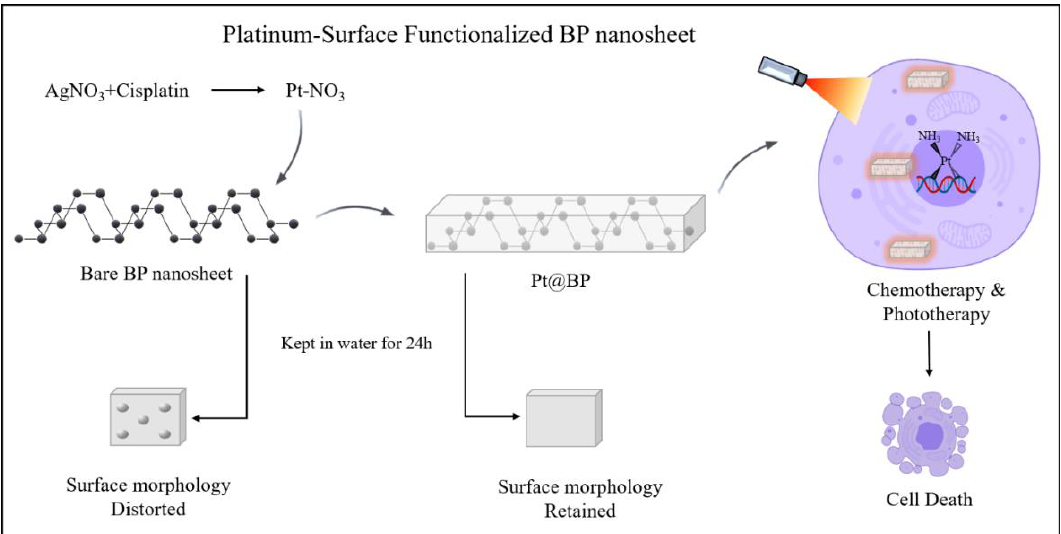
Figure 3. Modified cisplatin surface-modified BP nanosheet for synergistic chemotherapy and phototherapy.